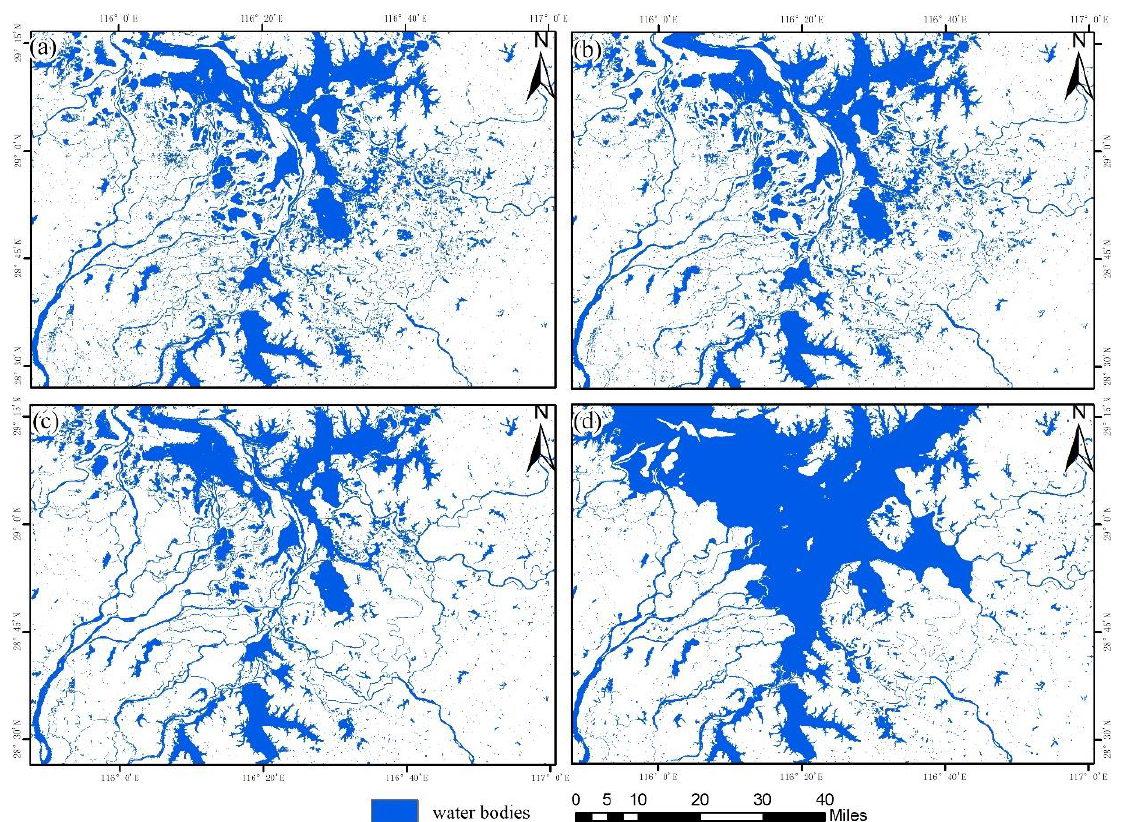
Figure 6. The comparison of surface water portrayals of the Poyang Lake basin from this study ( a ), JRC GSW ( b ), ESA WorldCover ( c ), and GlobeLand30 ( d ) products.